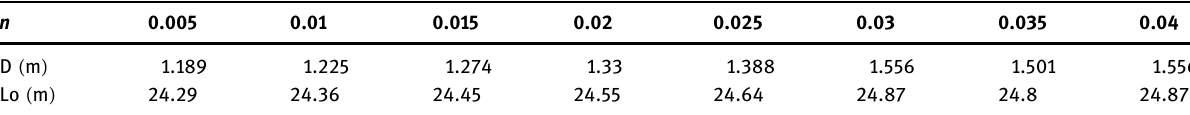
Table 6: Manning coe ffi cient vs optimum diameter and safe span